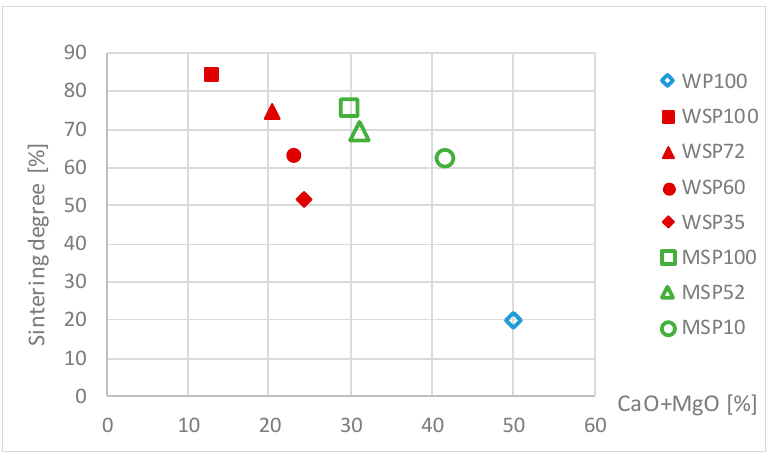
Figure 12. Mean sintering degree of bottom ash versus CaO + MgO concentration in fuel preliminary analysis (Table 3) for each fuel.